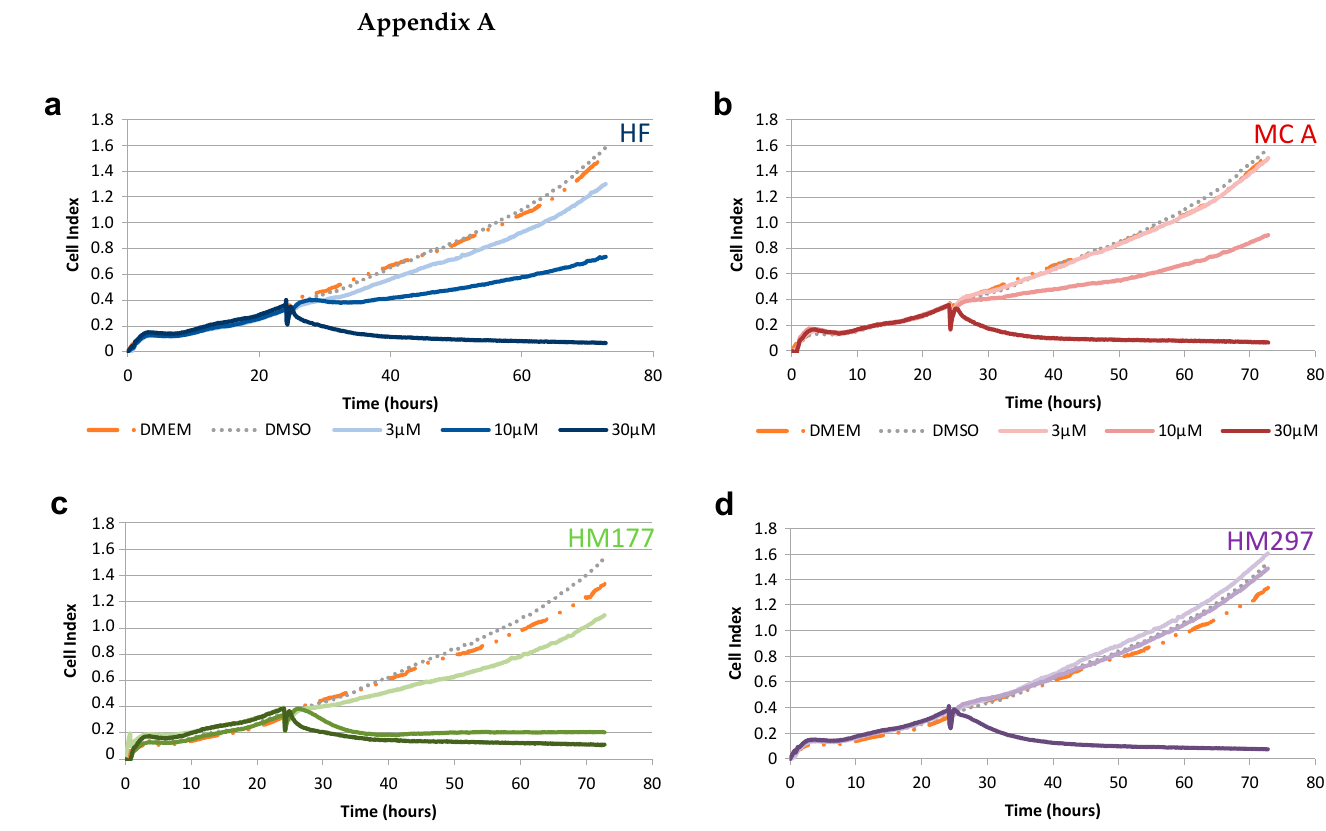
Figure A1. Analysis of cell proliferation of STF293 cells using real-time impedimetric measurement using the xCELLigence system in response to treatment with the indicated concentrations of ( a ) HF, ( b ) MC A and its derivatives ( c ) HM 177 and ( d ) HM 297. The graphs show representative cell index values of experiments performed in duplicate.